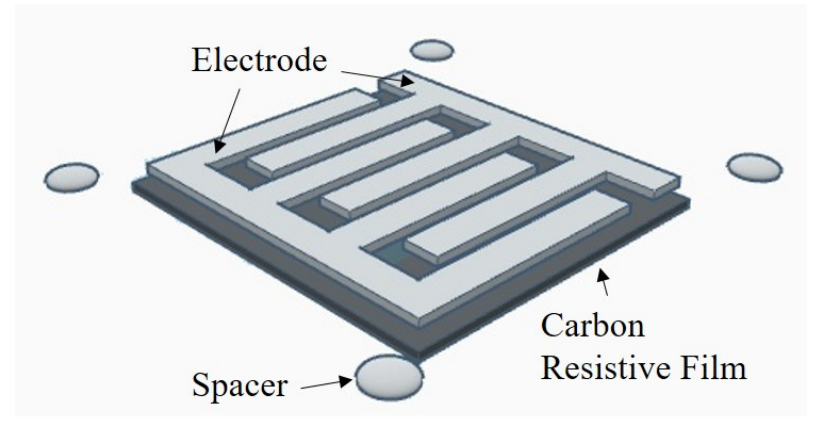
Figure 4. Structure of the single force-sensing resistor.